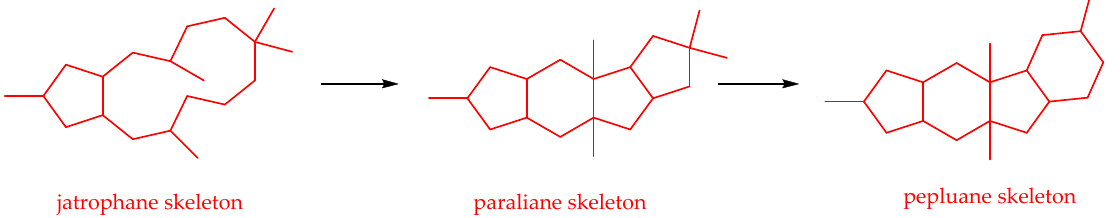
Scheme 5. Formation of pepluane skeleton.